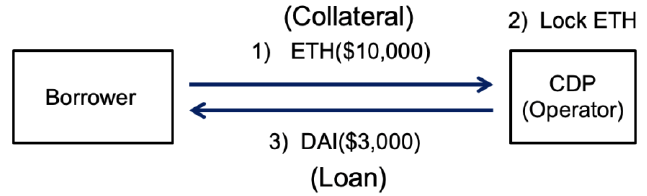
Fig. 1. Loan structure and process of a conventional crypto-secured lending system, MakerDAO. The investment of collateral is a one-way operation for freezing and